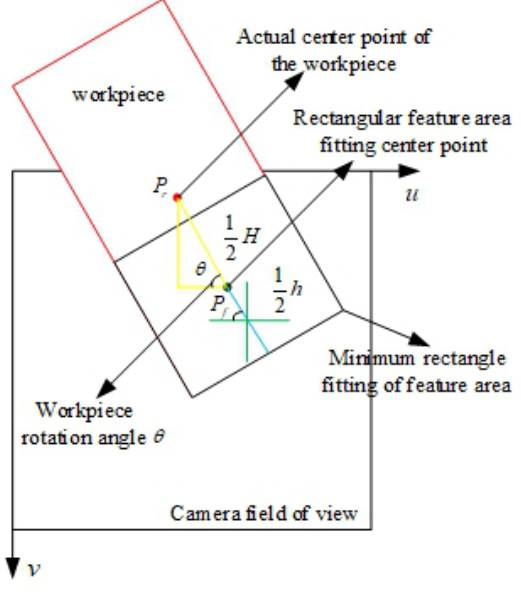
Figure 7. The schematic of pose